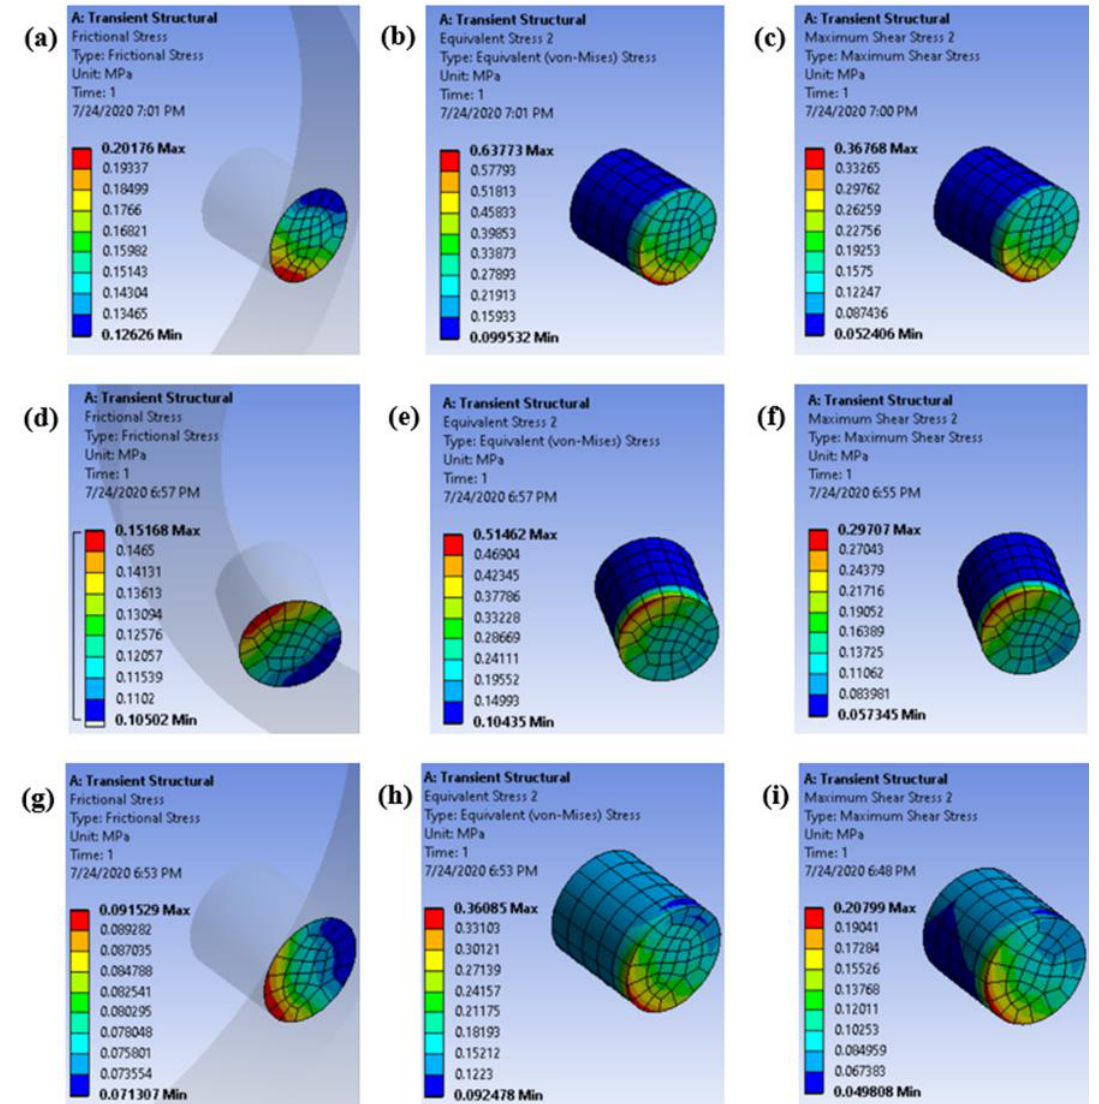
Figure 18. Stress distribution along the Al/SiC composite surfaces; ( a – c ) LHSBM, ( d – f ) LHLSBM, and ( g – i ) LHHSBM.